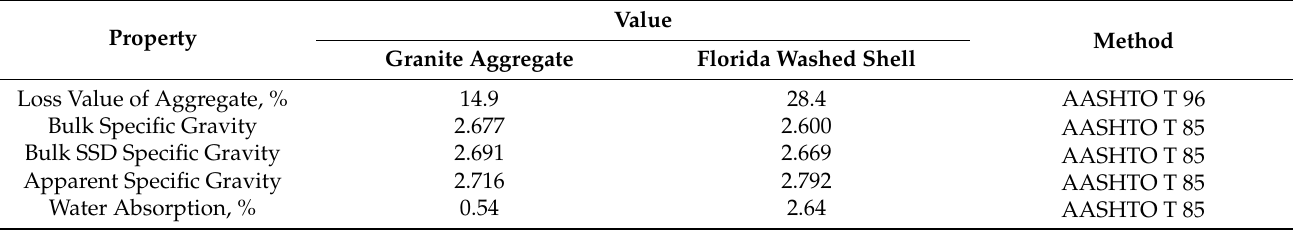
Table 2. Physical properties of granite aggregate and Florida washed shell.